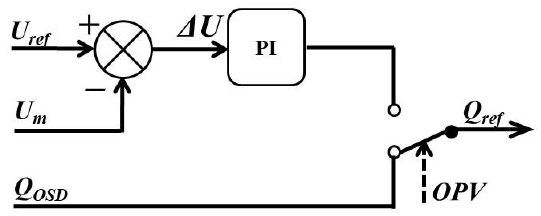
Figure 4. The wind farm reactive power control system.